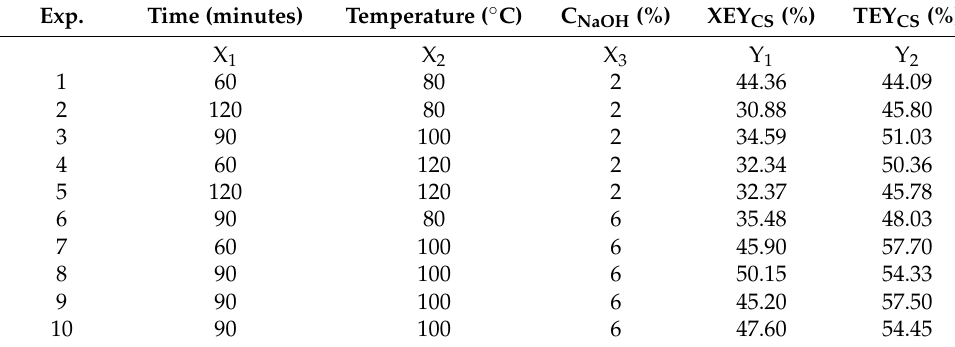
Table 4. Xylan and total extraction yield results for CS HAE.